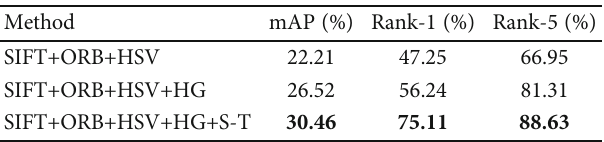
Table 3: ReID accuracy of Tong Zhou G103 vehicles entering Beijing.